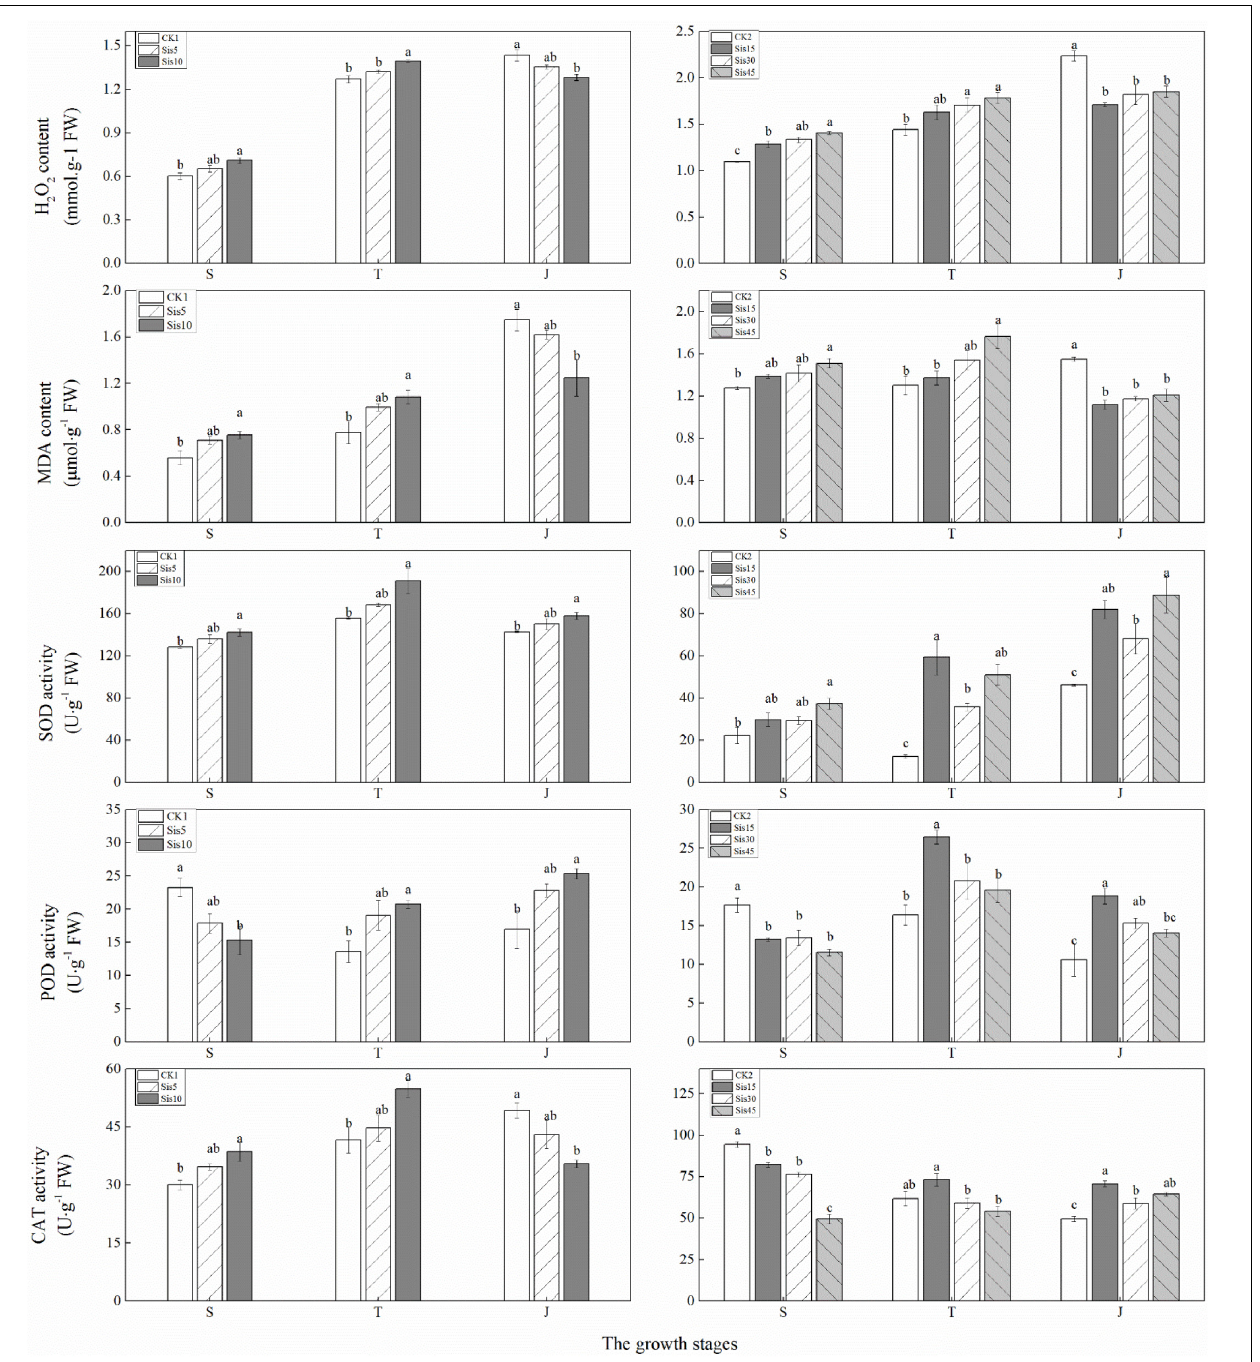
FIGURE 5 | Effects of silicon application on malondialdehyde (MDA) and H 2 O 2 levels and superoxide dismutase (SOD), peroxidase (POD), and CAT activity in sugarcane leaves under Sporisorium scitamineum stress. Various lowercase letters represent significant differences at a P level of 0.05. S, seedling stage; T, tillering stage; J, jointing